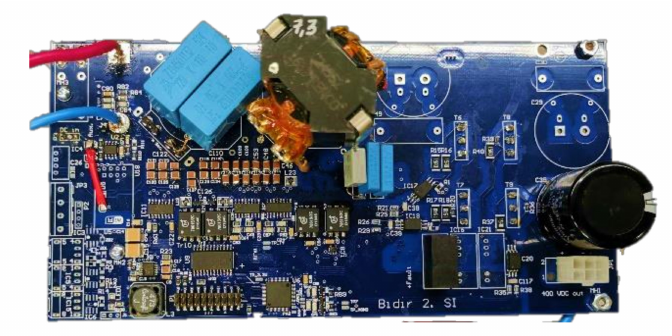
Figure 7. Prototype of the SRC